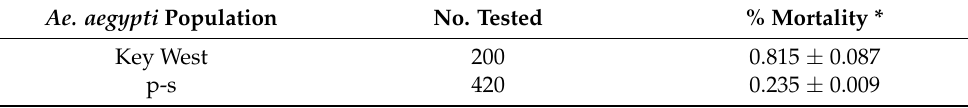
Table 1. Mortality of Ae. aegypti populations following exposure to permethrin.